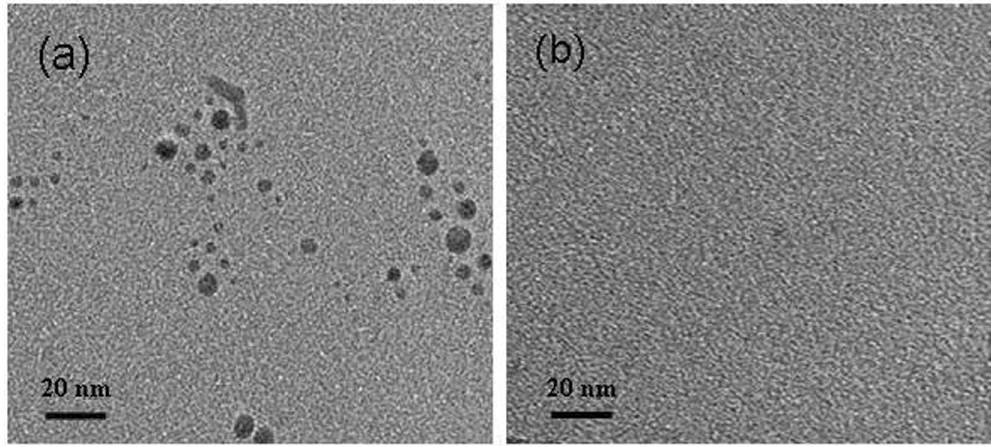
Figure 3. Transmission electron microscopy images of ( a ) AgNPs and ( b ) AgNPs in the presence of H 2 O 2 .